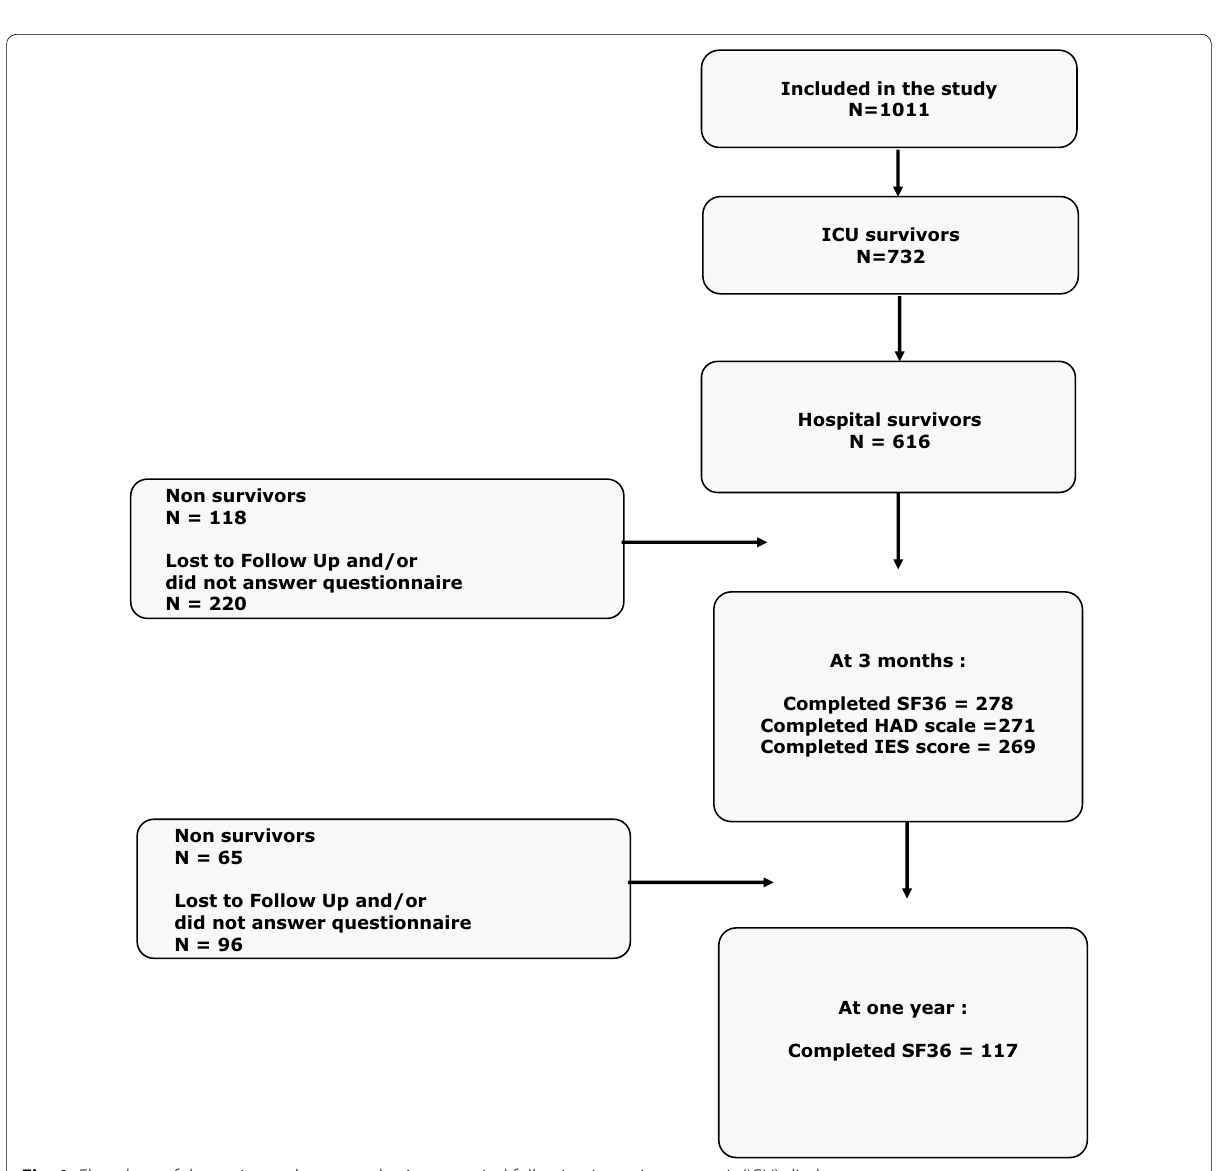
Fig. 1 Flowchart of the patient cohort over the 1 year period following intensive care unit (ICU)